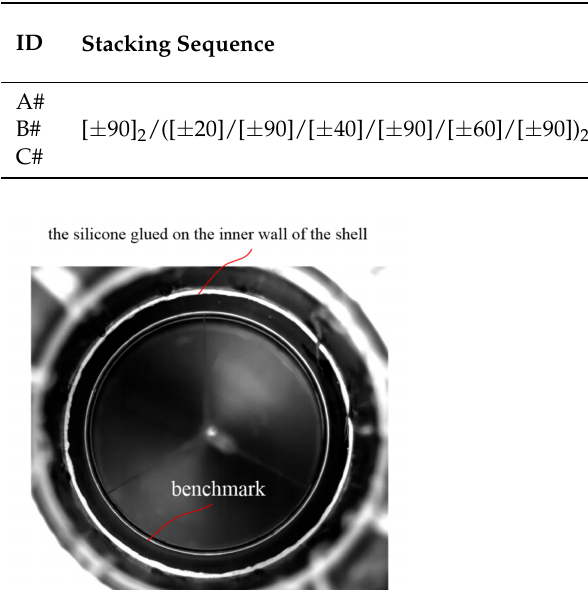
Table 2. Experimental and numerical simulation results.